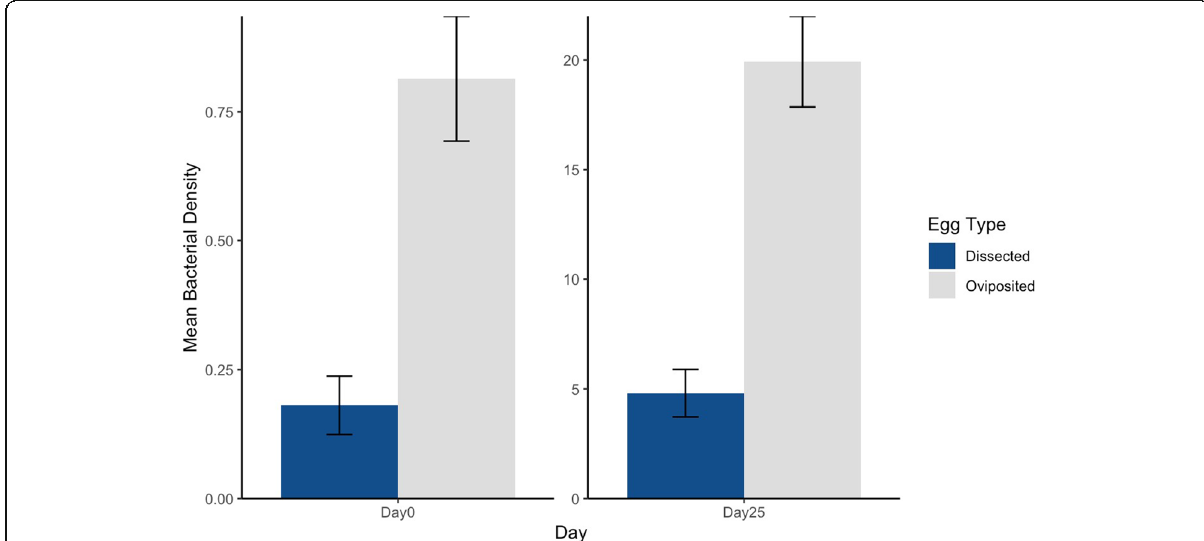
Fig. 2 The mean ( ± SE) density of bacteria (per 1800 μ m 2 ) on S. virgatus eggshells at Day 0 and Day 25 of incubation in soil slurry. Bacteria were significantly less dense on dissected eggs than on oviposited eggs on both days ( p < < 0.001). Counts were made via SEM by randomly selecting locations on the eggshell surface and measuring the density of bacteria at 2.5 k